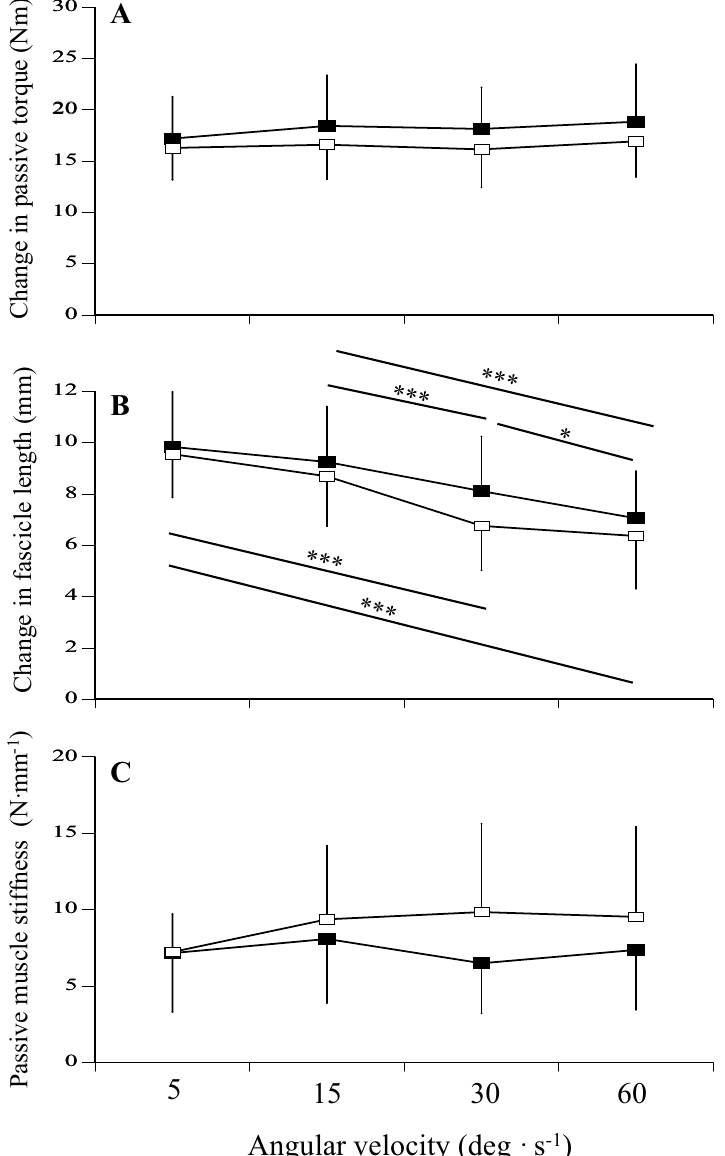
Figure 1. Changes in passive torque ( A ) and fascicle length ( B ), and passive muscle stiffness ( C ) at 5, 15, 30, and 60 deg s −1 in middle-aged (closed) and young (open) men. Significant difference among the conditions: *p < 0.05, ***p <